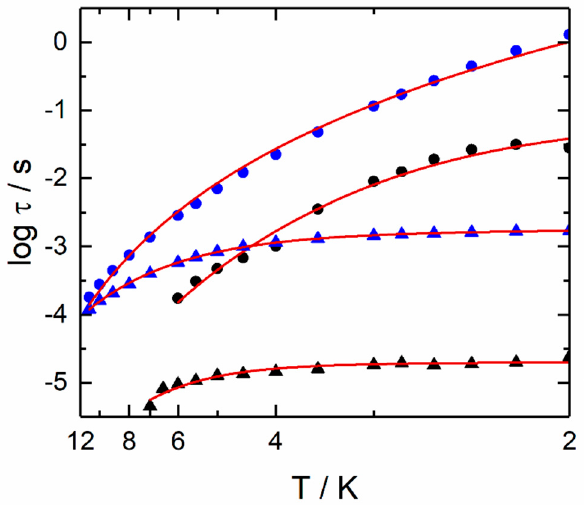
Figure 3. Temperature variation of the relaxation time for 1 (blue spots, temperature range 2–12 K) and 2 (black spots, temperature range 2–7 K) in zero (triangles) and 1000 Oe (full circles) applied magnetic field.